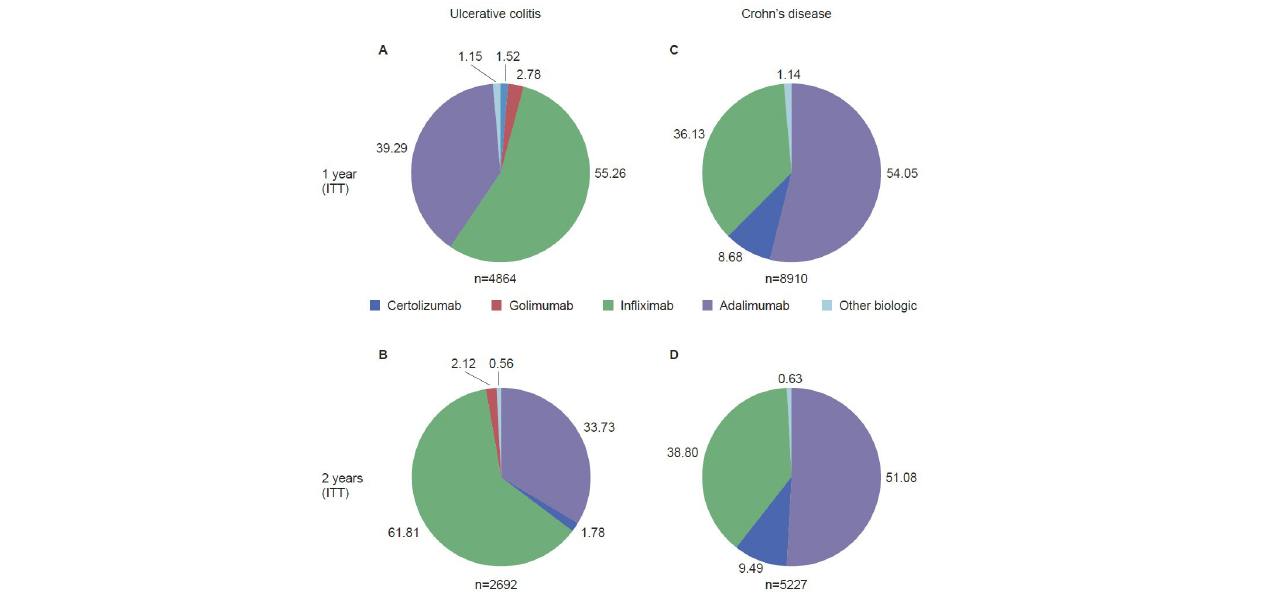
Figure 2. Biologics Initiated in Patients with UC and CD in the 1-year and 2-year Cohorts